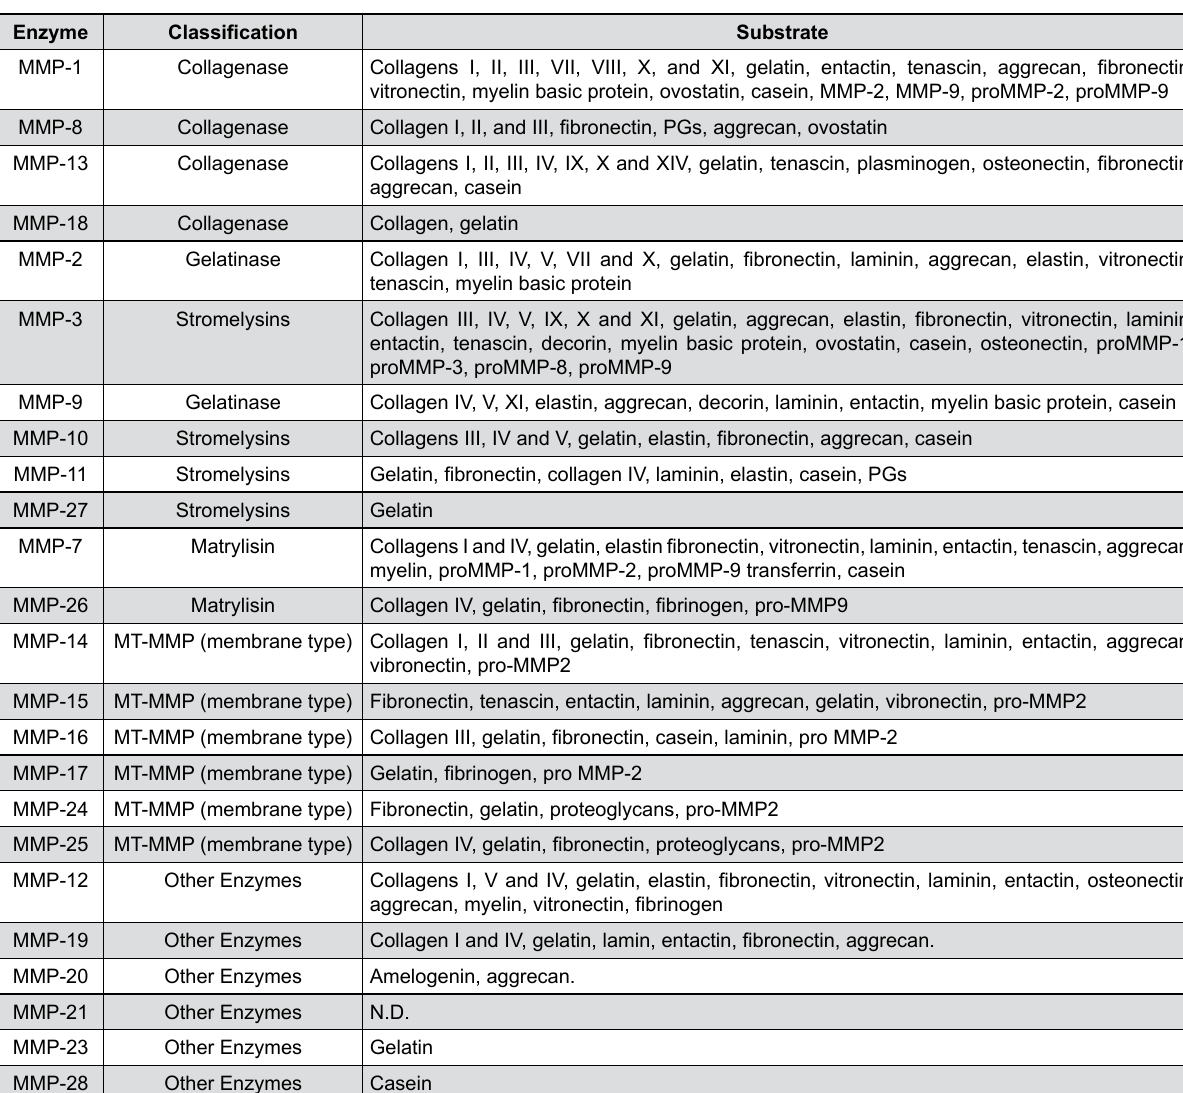
Figure 2- List of MMPs, according their classification and substrate